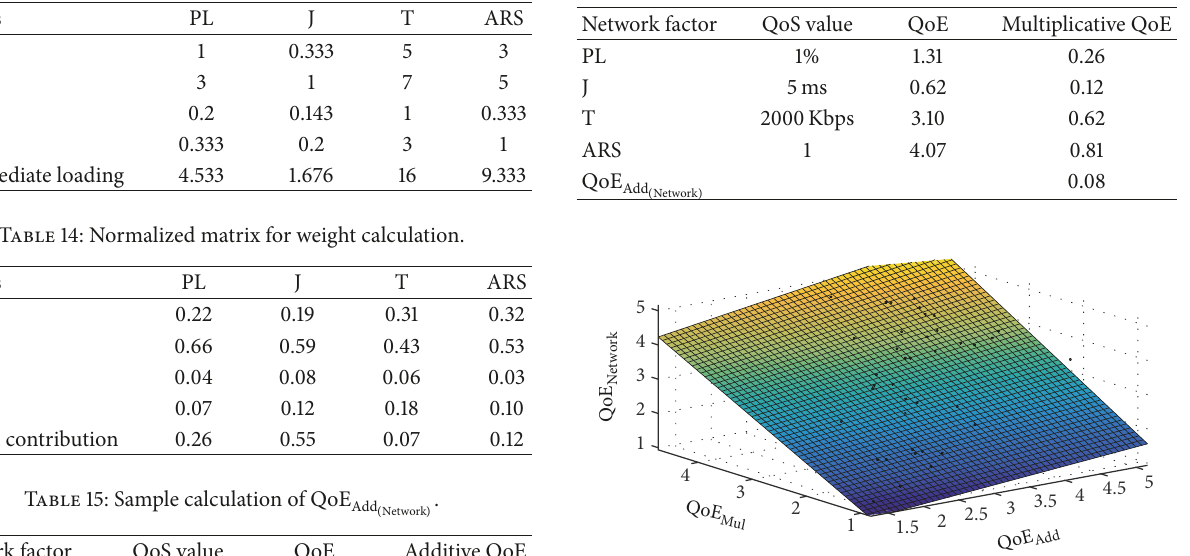
Table 16: Sample calculation of QoE